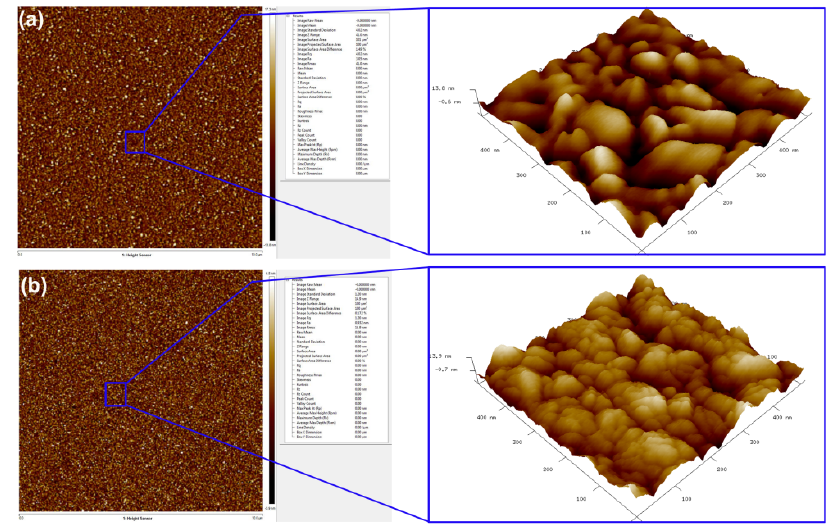
Figure 2. XRD patterns of the as-deposited CrN and CrN–Pt coatings.